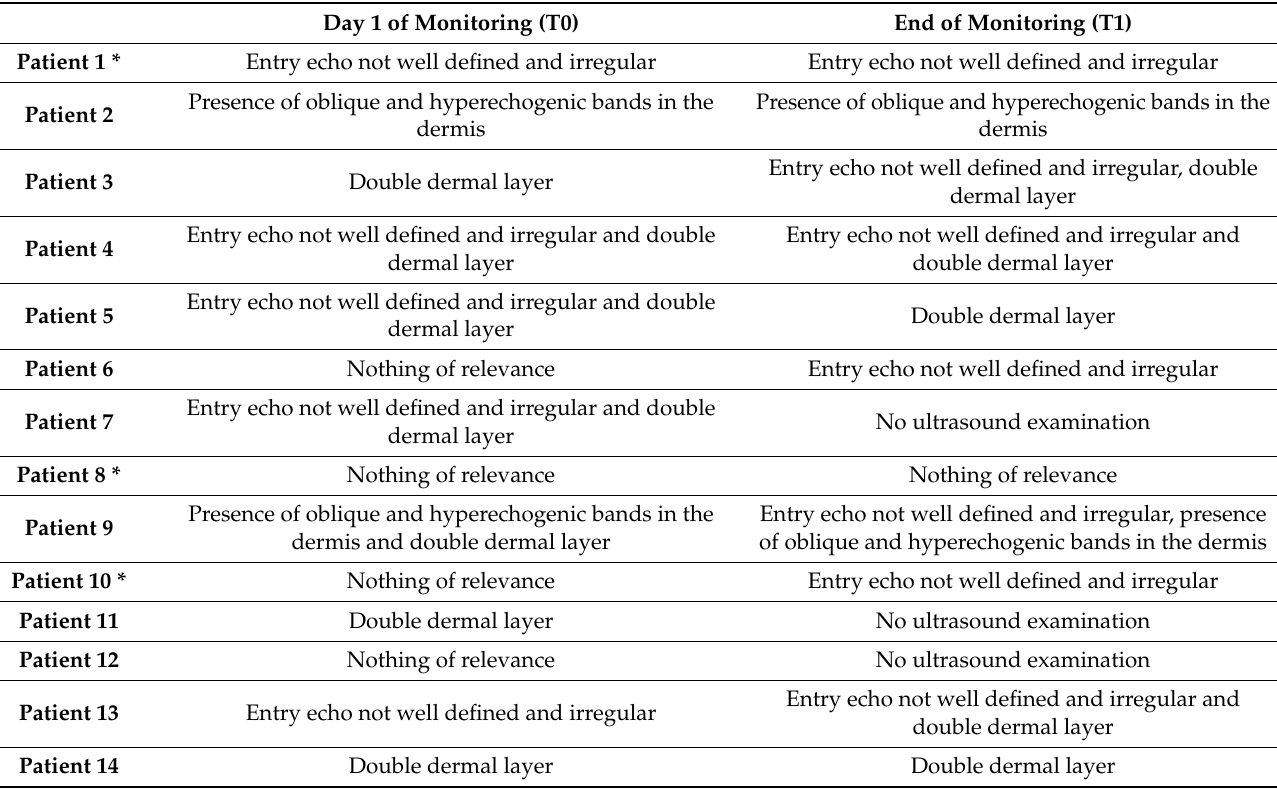
Table 2. Ultrasonographic characteristics of the skin of each dog at T0 and T1. * Dogs that developed macroscopic erythema at T1. (Nothing of relevance = consistent with normal features reported in previous